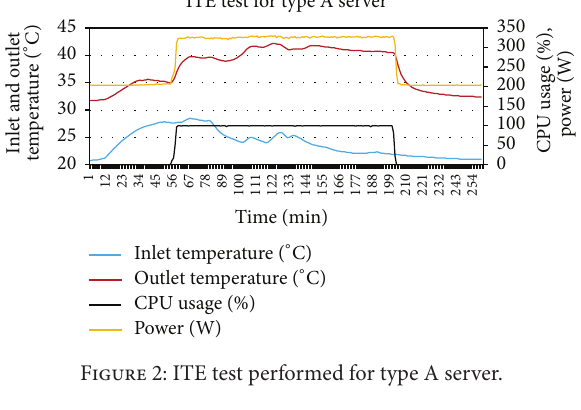
Figure 2: ITE test performed for type A server.